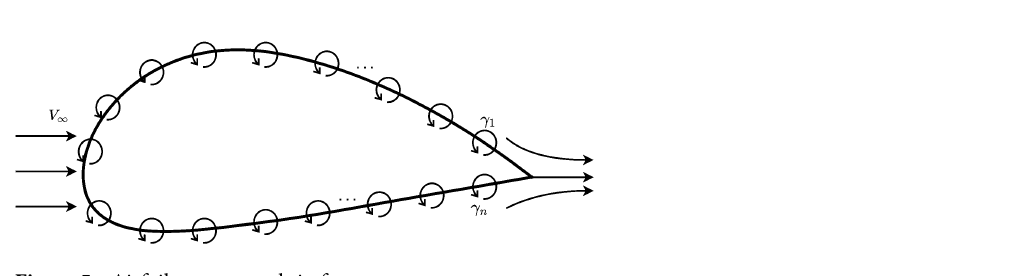
Figure 5. Airfoil vortex panels in free